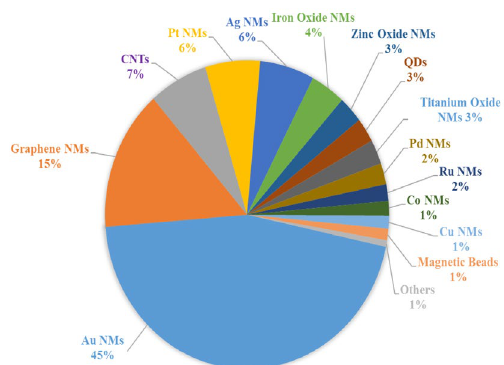
Figure 5. The most commonly used nanomaterials in biosensor fabrication and their frequencies. Data collected from Web of Science